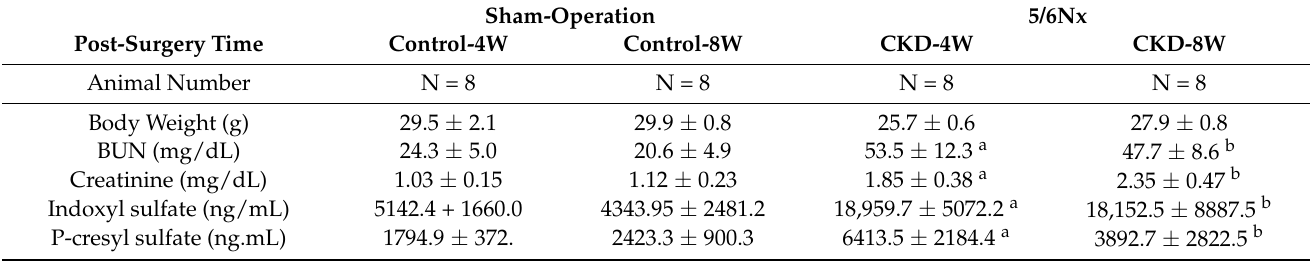
Table 1. The physiological parameters of 5/6 nephrectomy animals revealed accumulation of blood urea nitrogen (BUN), creatinine, indoxyl sulfate (IS), and p-cresol sulfate (PCS) in the circulation system. a , p < 0.05 vs. control-4W; b , p < 0.05 vs. control-8W.